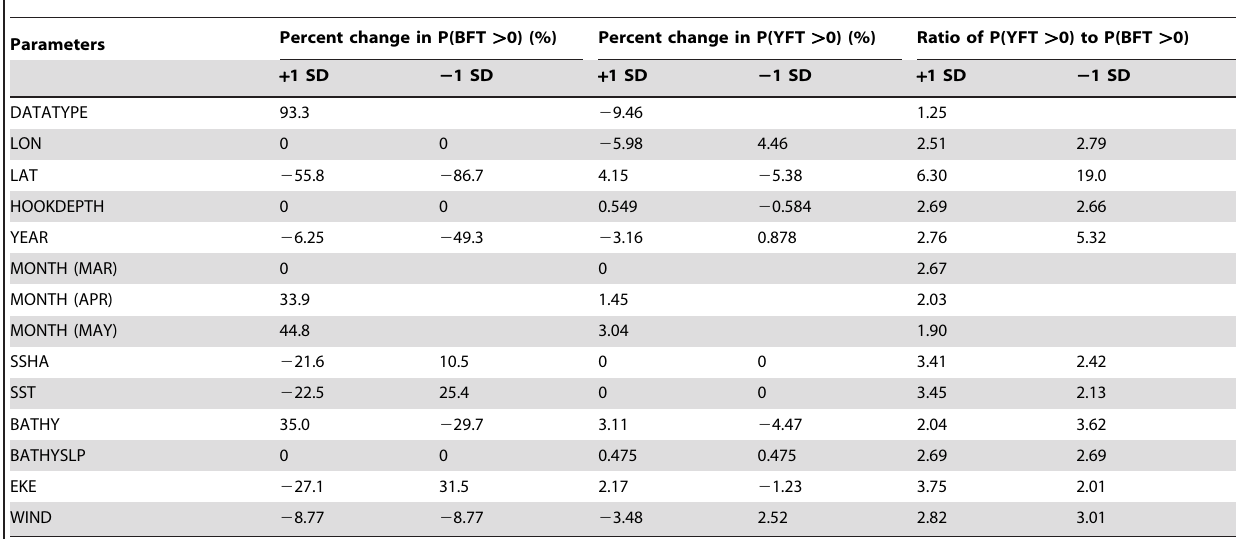
Table 4. Sensitivity analysis of environmental parameters on the probability of catching one or more BFT and YFT.